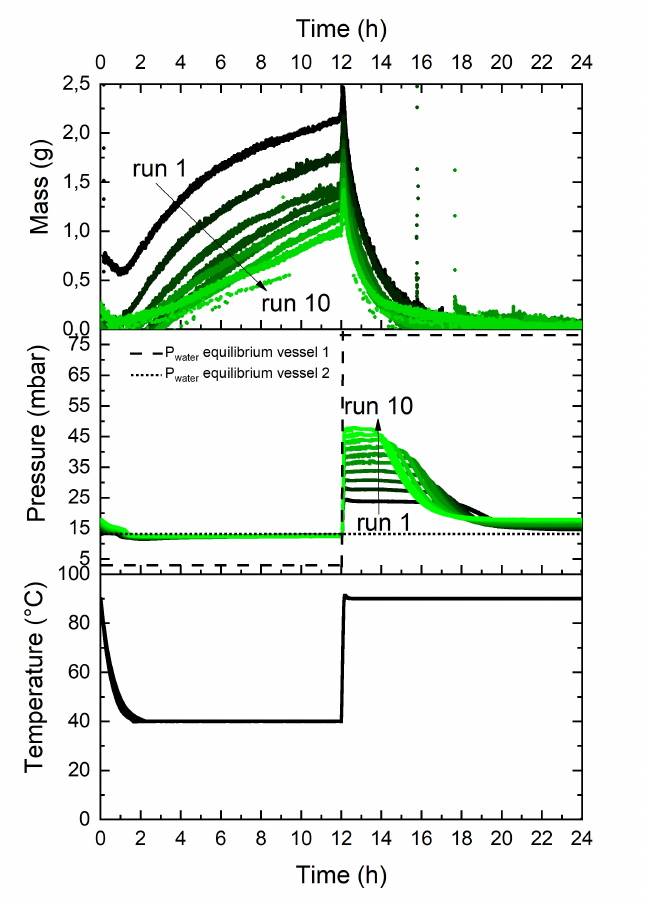
Figure 4. The temperature, pressure and change in mass of a thermochemical material (TCM) with a mass of vessel 2 initially filled with 21.5 g dehydrated K 2 CO 3 and vessel 1 with water during 10 cycles of dehydration/hydration. The peak at 0 and 12 h in the change in mass curve is a result of the heater which is turned on and off as result of hydration and dehydration. Each run has its own color whereby the color tranforms from black to green by increased run number. The data of this graph is re-used from J. Houben et al.